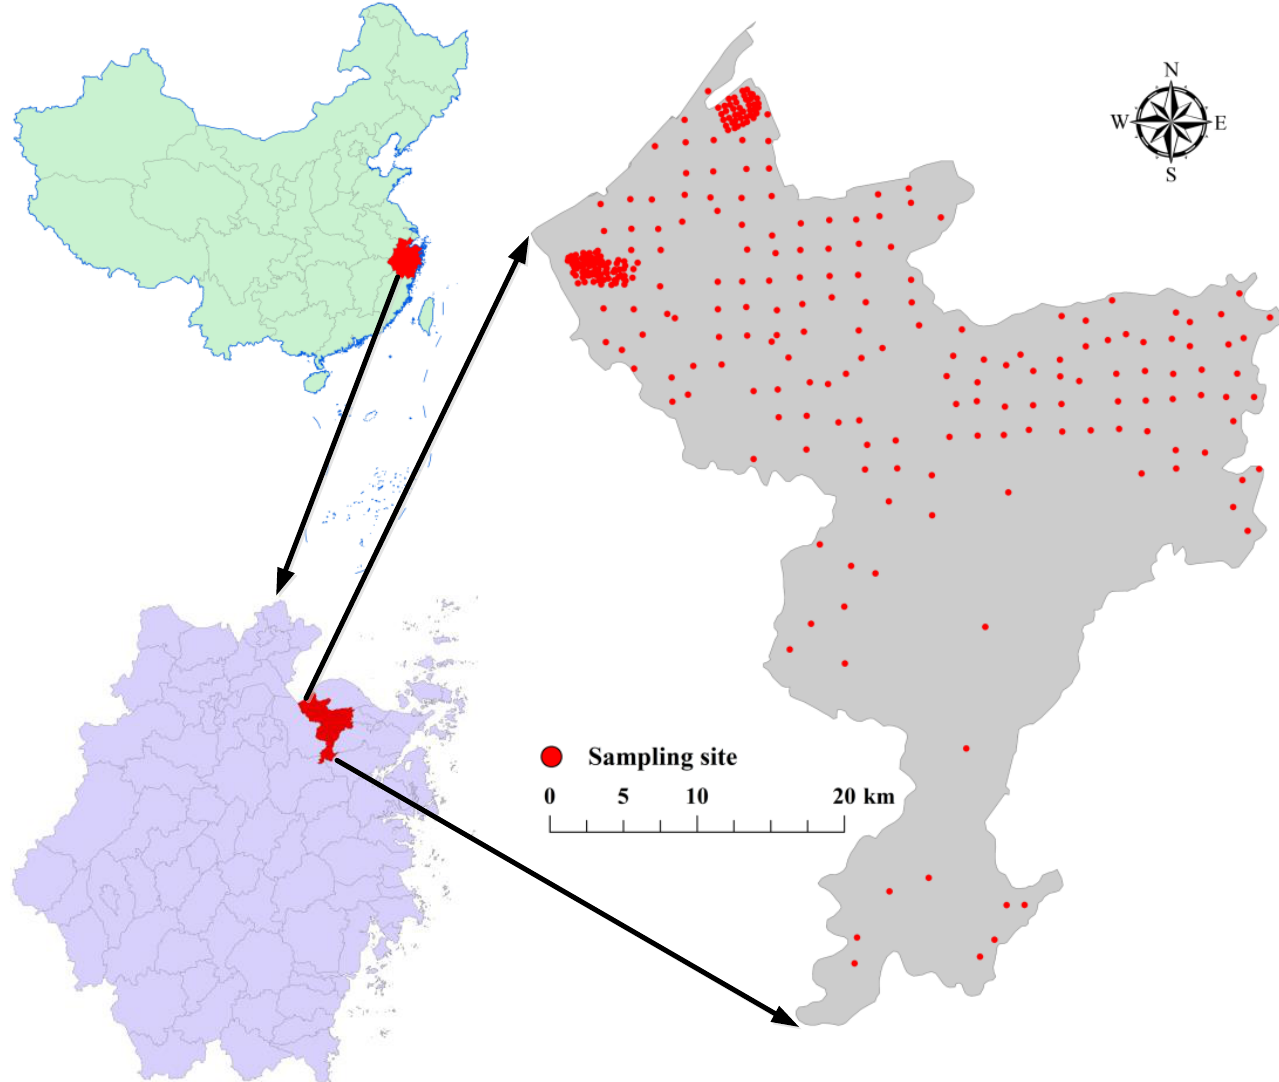
Figure 1. Study area and sampling location.